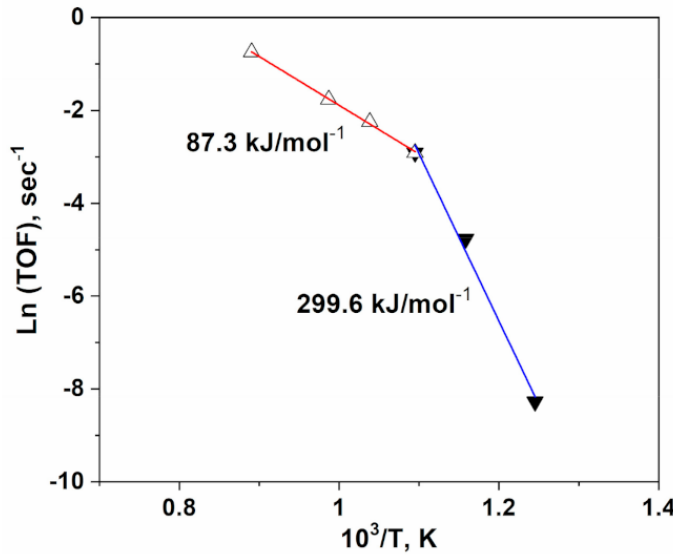
Figure 5. Variation of turnover frequency (TOF) for CH 4 conversion with temperature during the SCR of bio-syngas with 40% steam over the Rh/Al 2 O 3 monolith